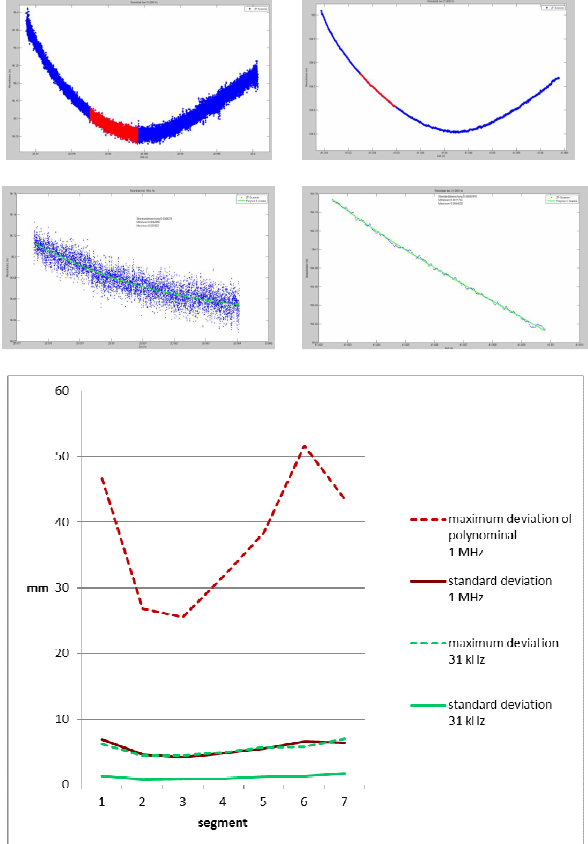
Figure 7: Top: recorded profile, left: 1 MHz, right: 31kHz; middle: partial sections of the profile, left: 1 MHz, right: 31kHz; bottom: maximum deviations from the polynomial and standard